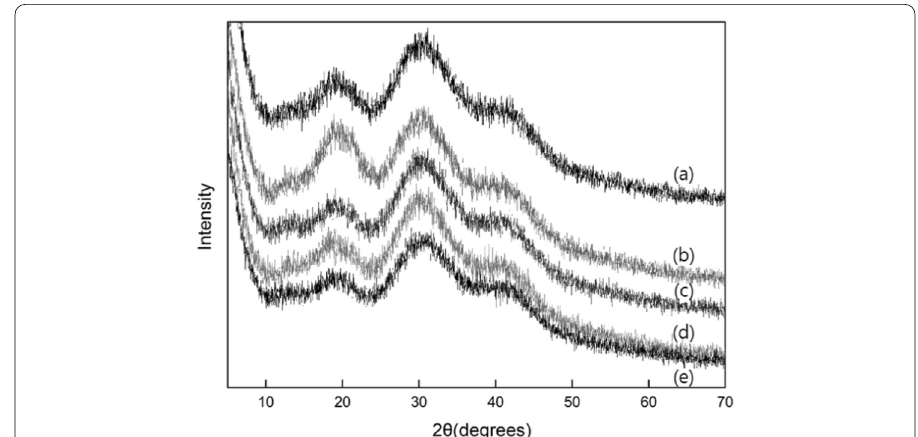
Fig. 5 XRD patterns of PU/AE nanofibers for different AE concentrations: a 0 wt%, b 0.5 wt%, c 1 wt%, d 2